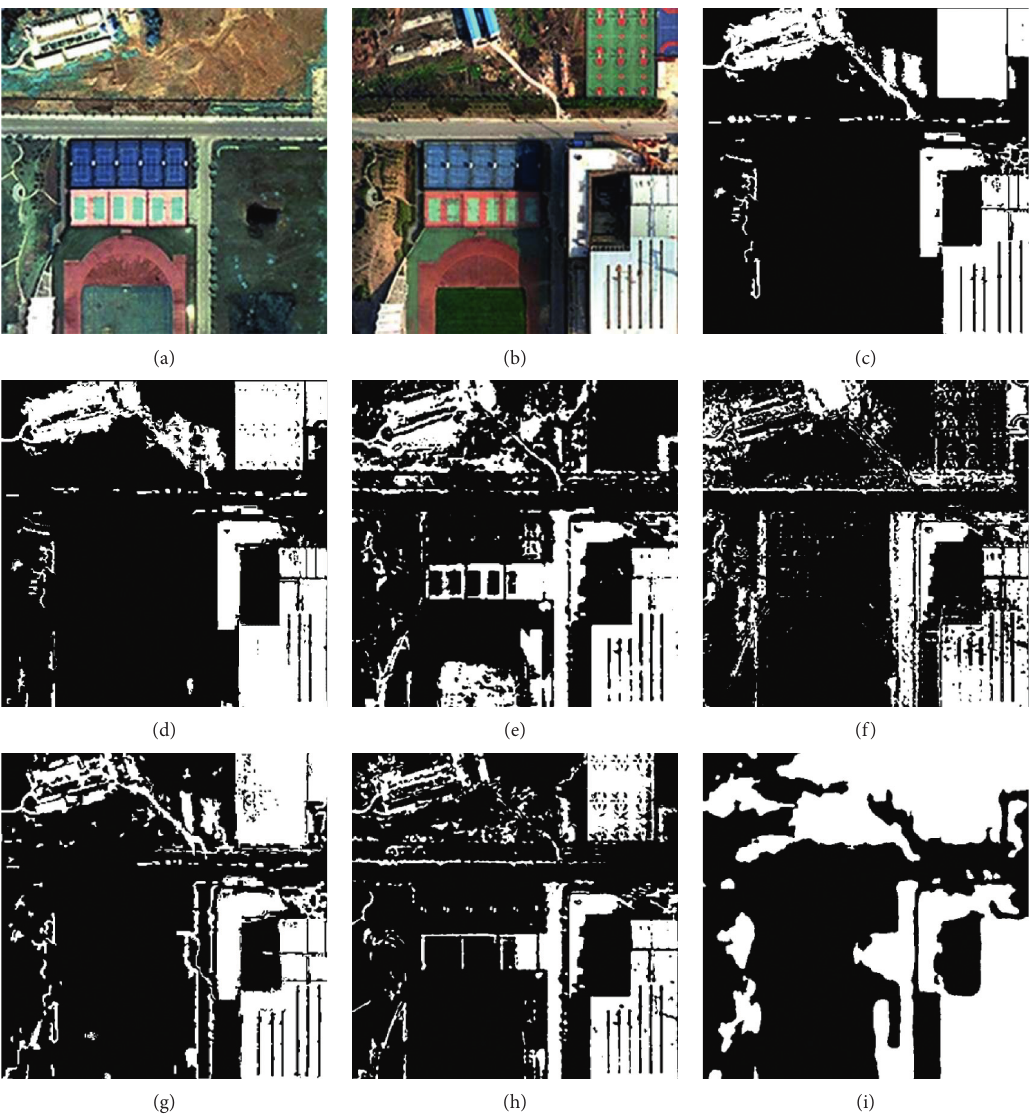
Figure 3: CD maps of dataset 1: (a-b) dataset 1; (c) reference map of dataset 1; (d–i) CD maps obtained in dataset 1 using the proposed method and Methods 1, 2, 3, 4, and 5,